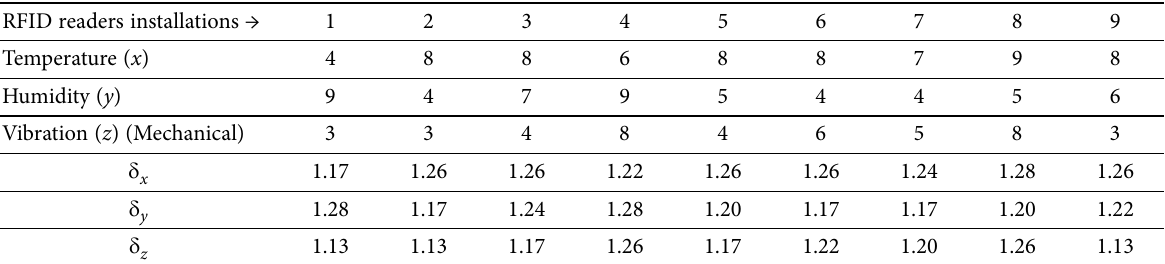
Fig. 3. A comparison of risk factors in the simulated Table 4. Simulated factors in cargo risk